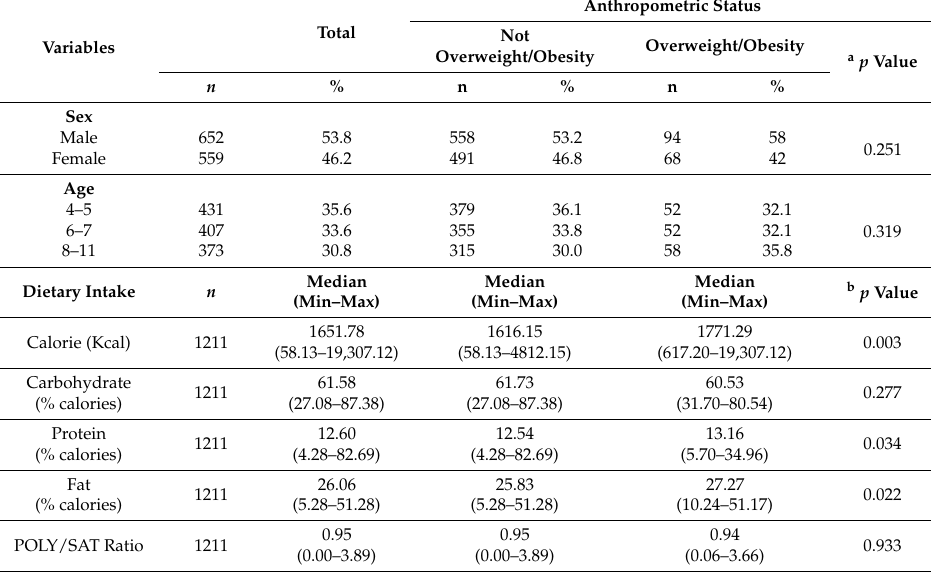
Table 1. Characteristics of the study population. Salvador, Bahia, Brazil,